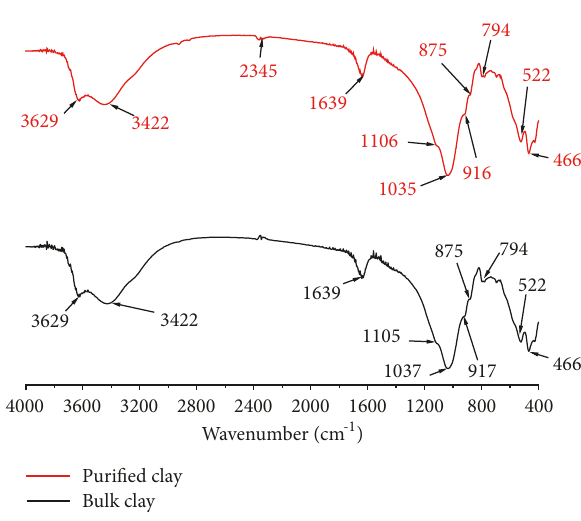
Figure 5: FT-IR spectra of the bulk and purified